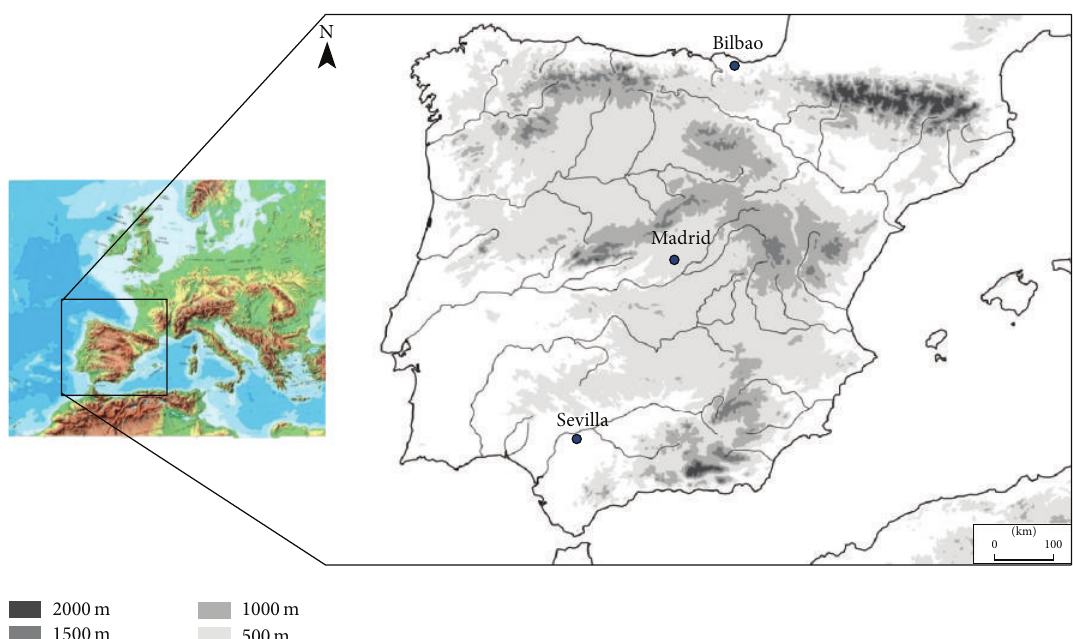
Figure 1: Map with the location of the stations and orographic characteristics of the Iberian Peninsula.